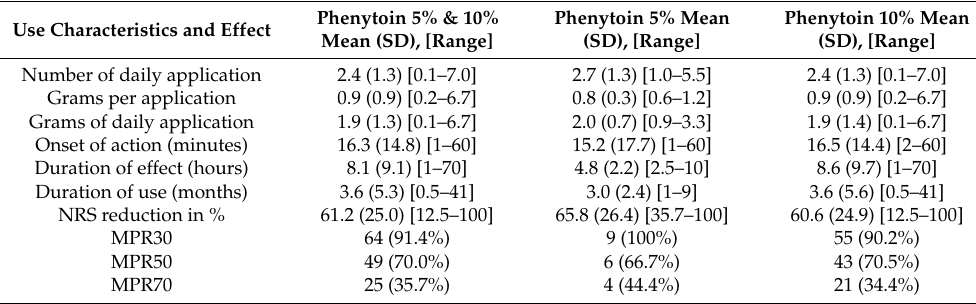
Table 3. Use and effect characteristics of phenytoin cream.